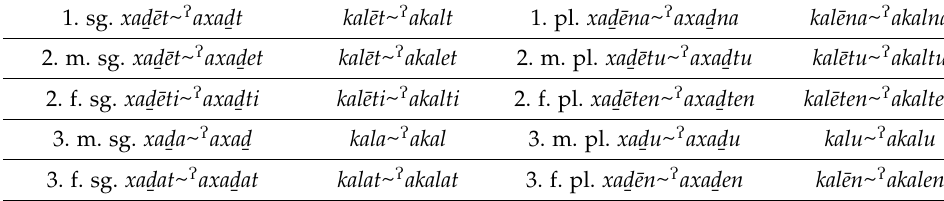
Table 5. Inflexion of perfective.